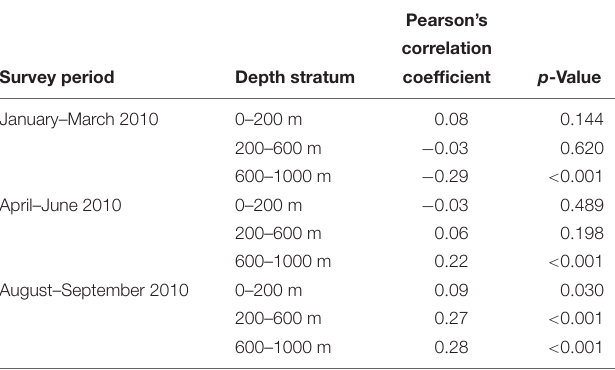
TABLE 3 | Summary of the correlation between Hellinger distance (dissimilarity) and geographic (Euclidian) distance for samples collected from each survey period and depth